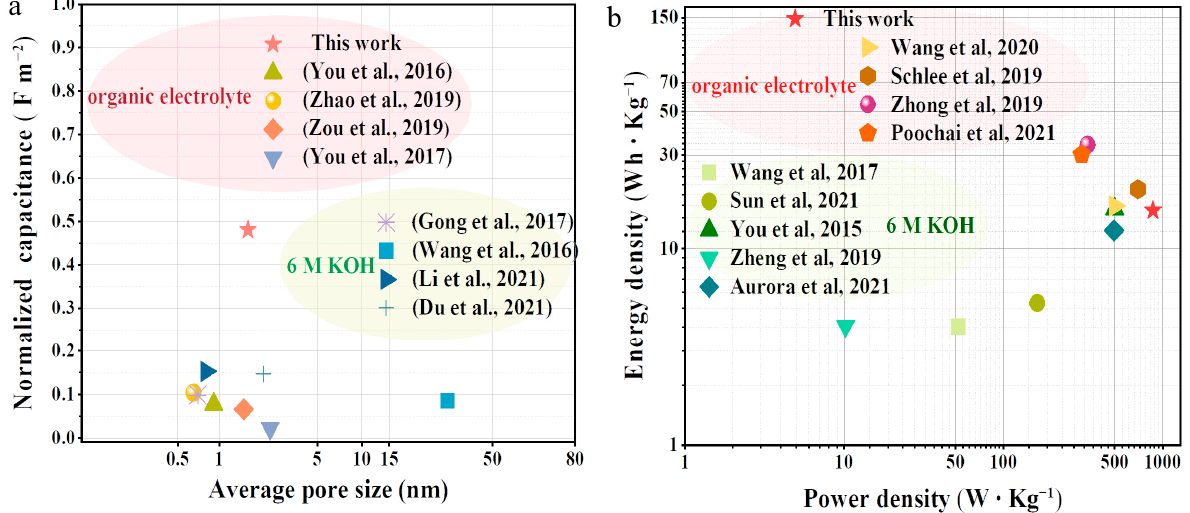
Figure 7. ( a ) Plots for specific capacitance normalized by surface area vs. average pore size [33,36,44,48,57,64,71,78]. ( b ) Ragone plots for the LCFs [3,34,47,50,55,70,72–74].